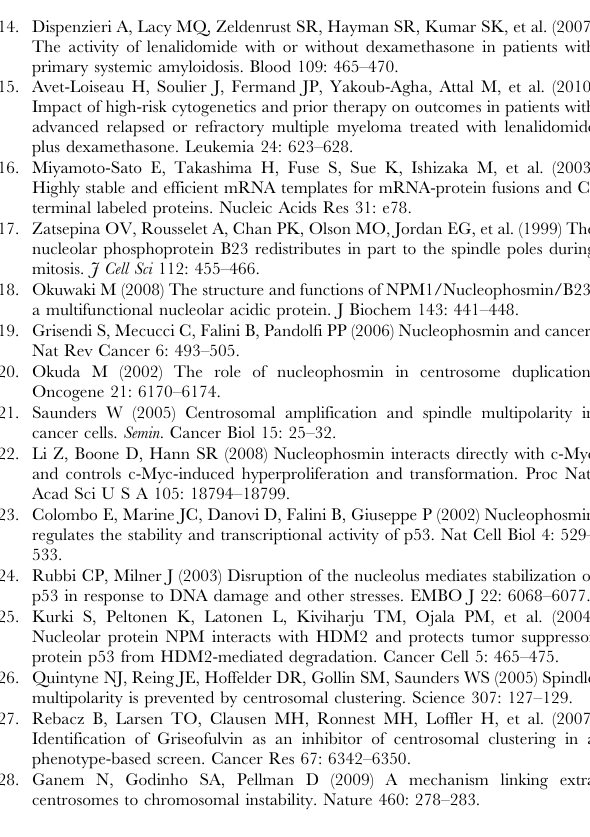
Figure S1 Chemical structures of phthalimide deriva- tives. (TIF) Figure S2 Screening of compound that inhibit multiple myeloma cell lines. (A) KMS34 cells (1 6 10 4 cells/well) in 96- well plate were incubated with 50 m M of each compound from phthalimide derivatives library for 0, 24, 48 or 72 h. Then cell viability was determined with WST-1 assay according to instructions provided by the manufacturer. (B) KMS34 or RPMI8226 cells were treated with 0, 5 or 50 m M TC11 or TC15 for 6 h, respectively. The whole cell lysates were analyzed by Western blot with anti-PARP antibody. (TIF)